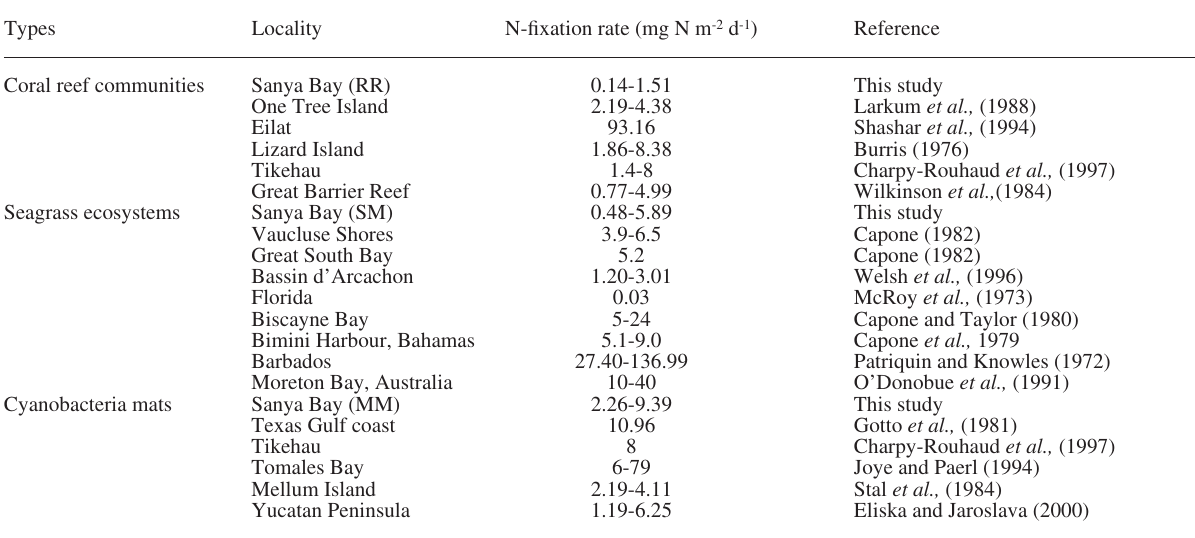
Table 7. – Comparison of nitrogen fixation rate estimates in various intertidal